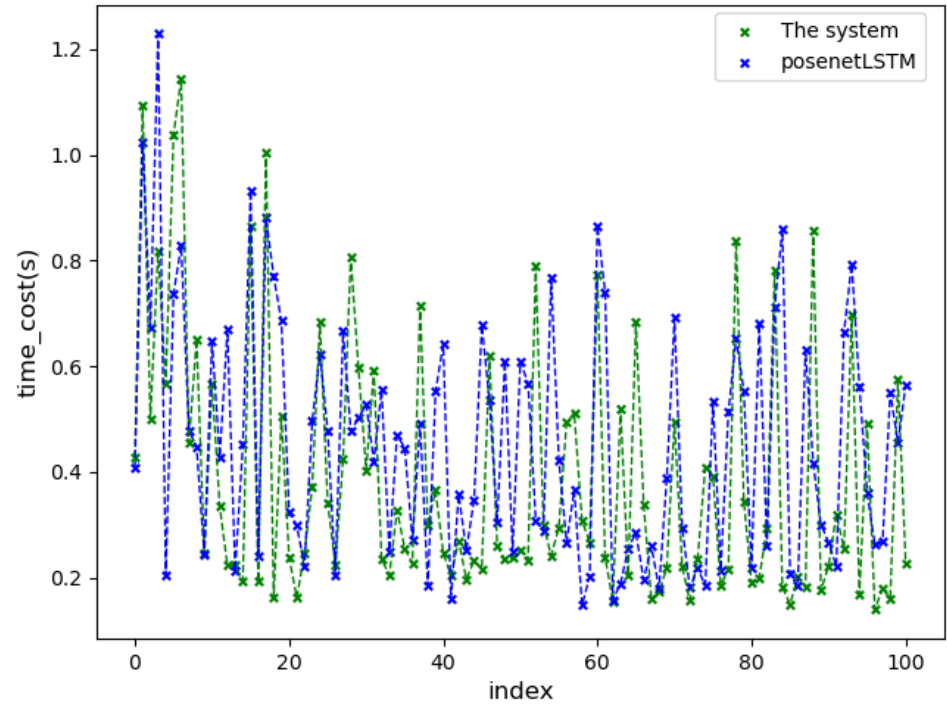
Figure 9. The change of pose from coarse to fine in the process of relocalization that combines laser and visual information. ( a , c , e ) The pose change in the x , y , and yaw directions, respectively, when using the posenetLSTM method; ( b , d , f ) The pose change in the x , y , and yaw directions, respectively, when using the method proposed in this paper.